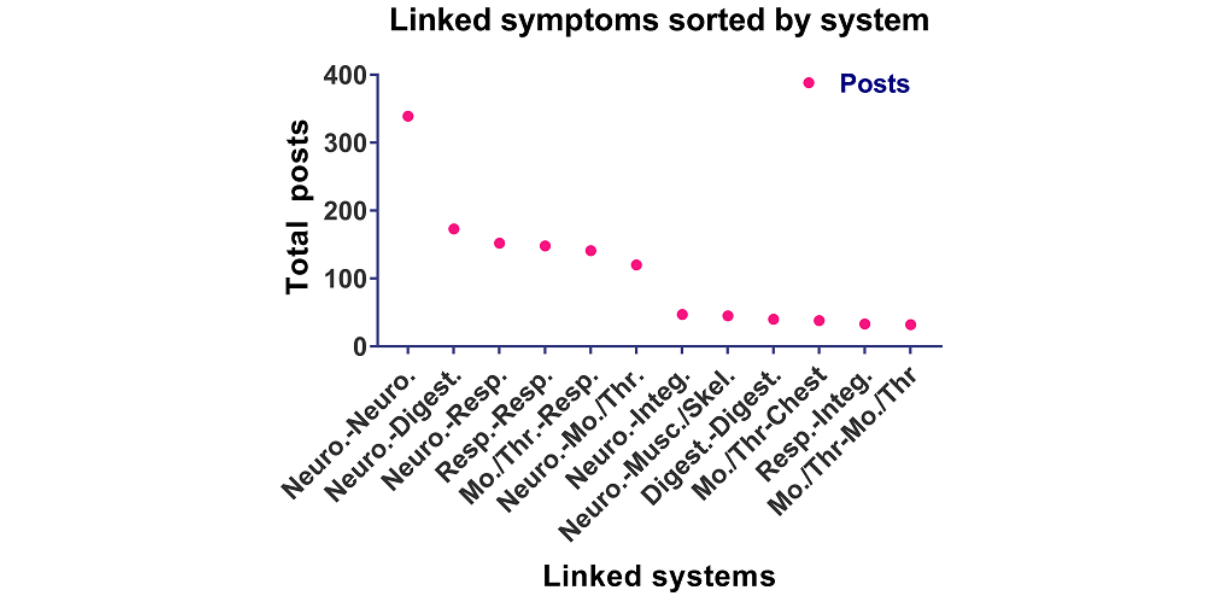
Figure 8. Graph showing frequency with which symptoms in various systems were linked. Digest.: digestive; Integ.: integumentary; Mo./Th.: mouth and throat; Musc./Skel.: muscular/skeletal; Neuro.: neurological; Resp.: